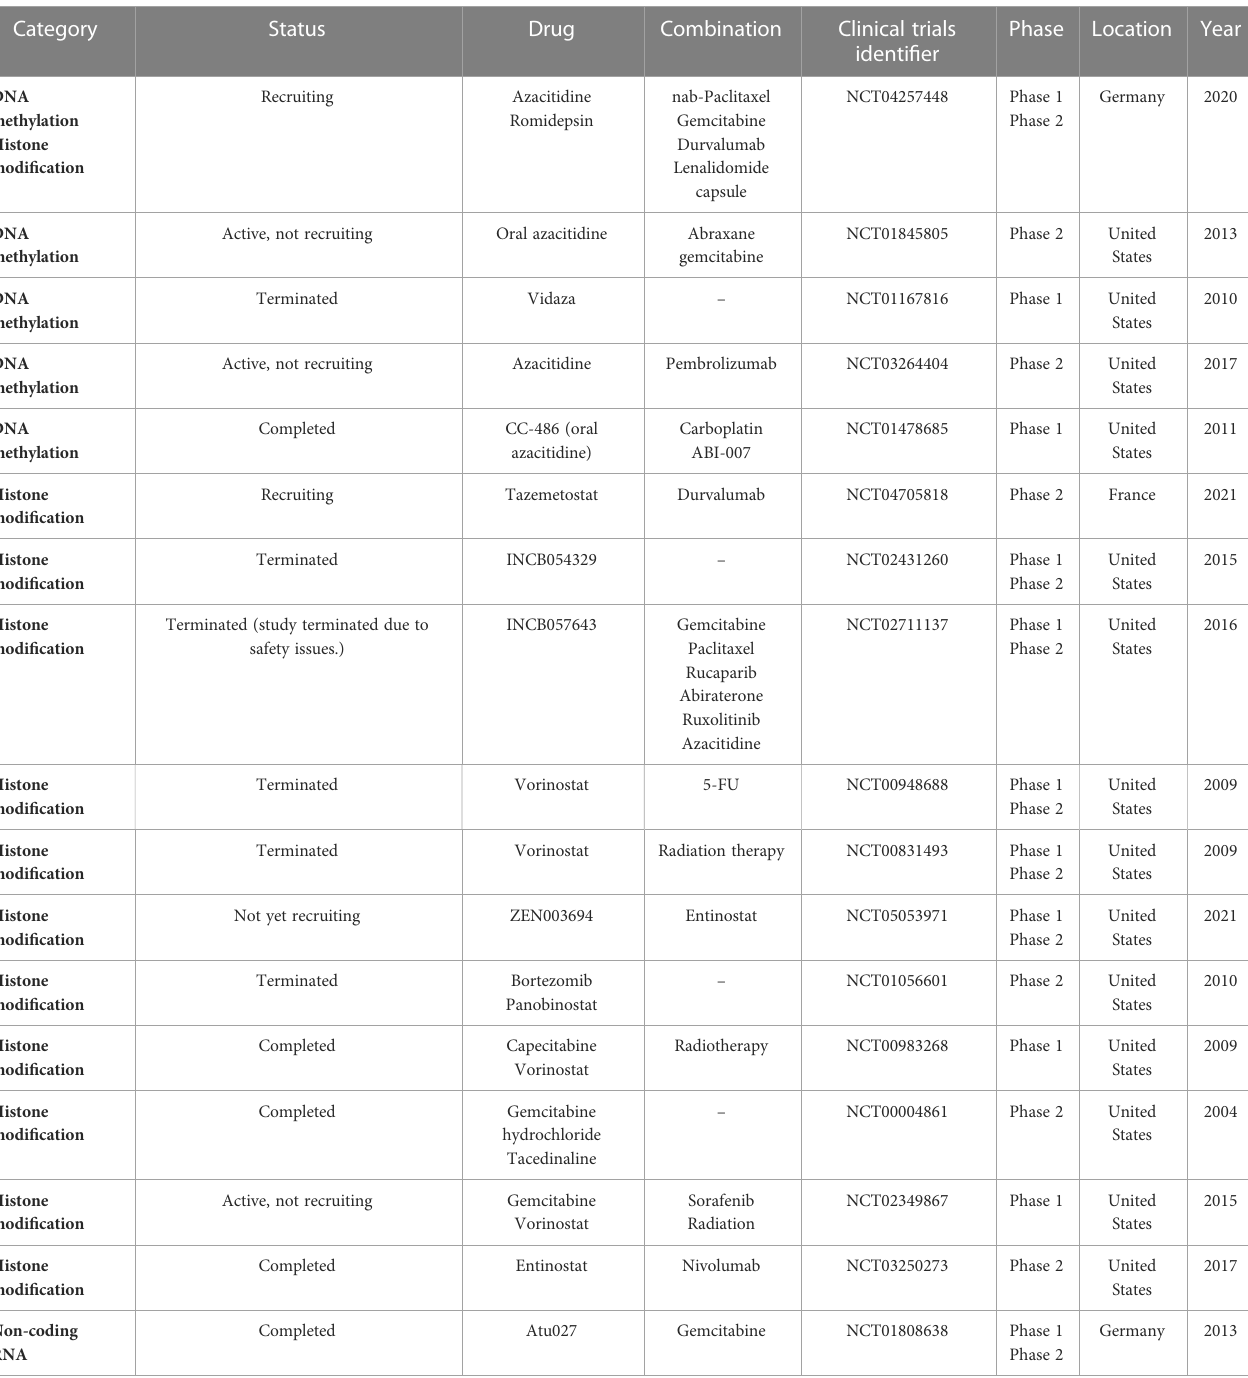
TABLE 3 Clinical trials on epigenetics as therapeutic targets in pancreas cancer.